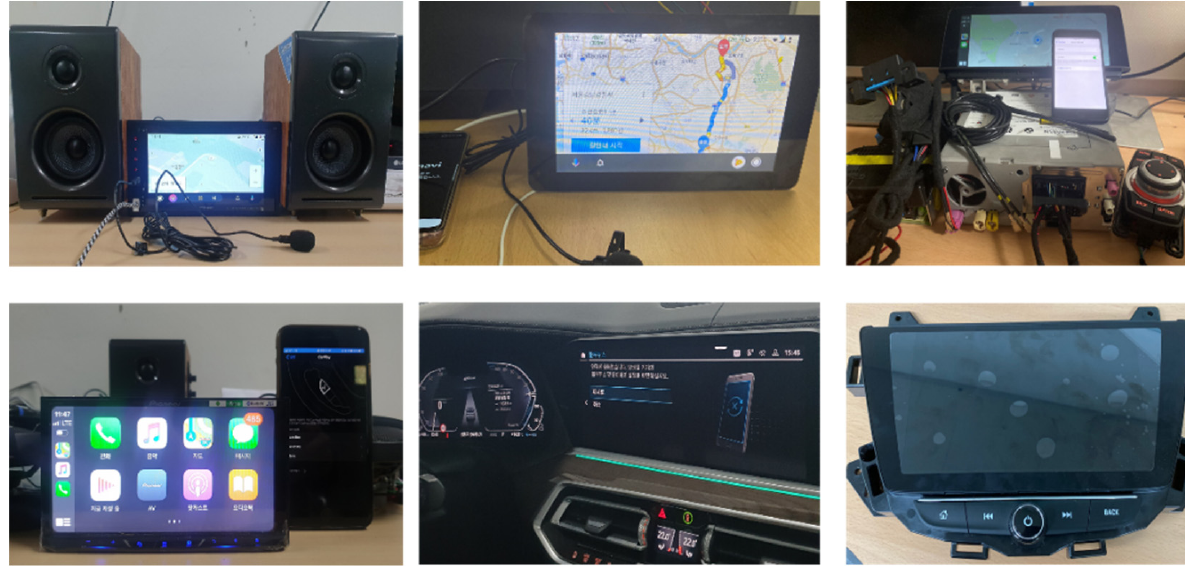
Figure 2. Test IVI environment for forensic analysis. Table 1. IVI system used in case studies and connectivity of the IVI system. Manufacturer